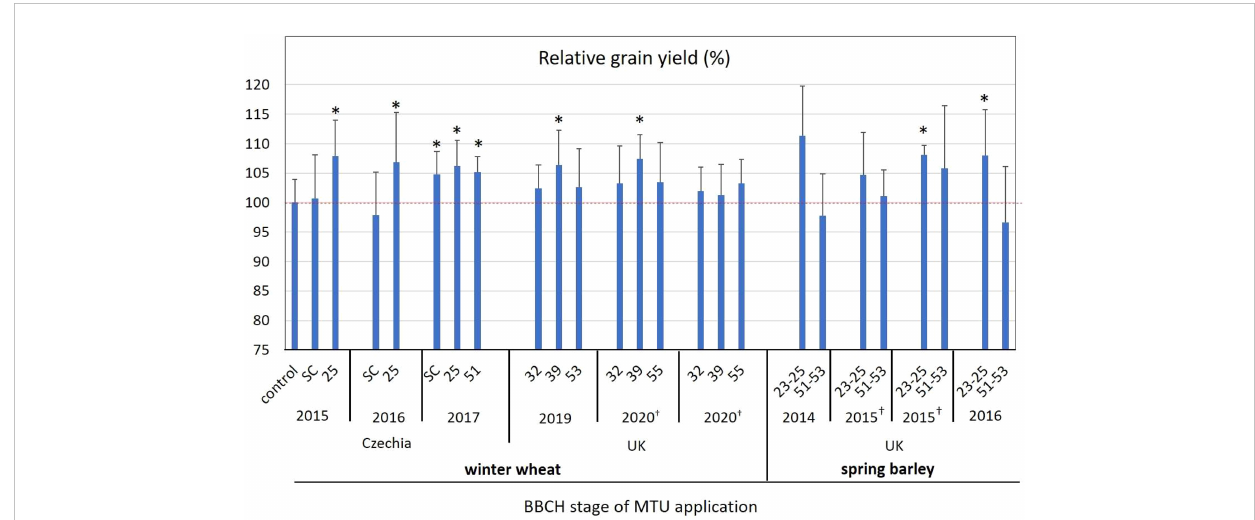
FIGURE 5 The effect of MTU on relative grain yield in fi eld-grown winter wheat and spring barley. Values are means of fi ve or six biological replicates ± SD. Asterisks indicate statistically signi fi cant differences determined by the two ‐ tailed Student ’ s t ‐ test at P -values of 0.15 > P . Red dotted line indicate 100% yield of untreated control. Complete data showing yields in t ha -1 , values for all control treatments and thousand grain weight are presented in Supplementary Table S5. SC, seed coating; † experiment was done at two different locations in the same region; UK, United Kingdom.